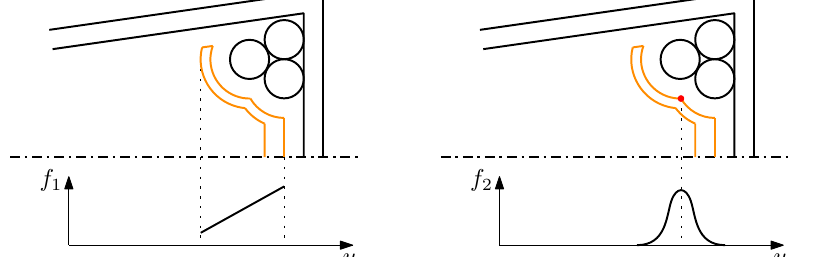
Figure 8. Weight functions for selection of new center.